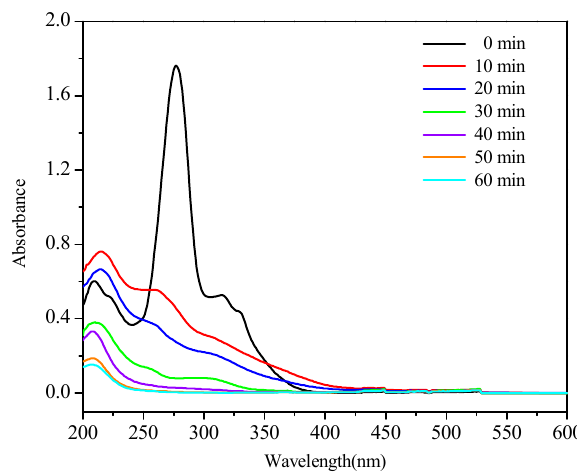
Figure 10. Time course (0, 10, 20, 30, 40, 50, and 60 min) absorbance spectrum of pretreated eye-drops sample during the degradation process in PFC / PS. Experimental conditions: [PS] = 3 mM, pH = 3, and electrolyte: 0.1 M Na 2 SO 4 .